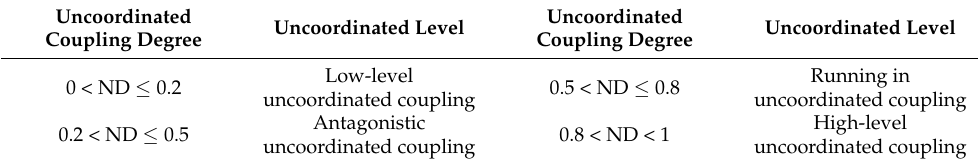
Table 1. Evaluation criteria for uncoordinated coupling. Uncoordinated Coupling